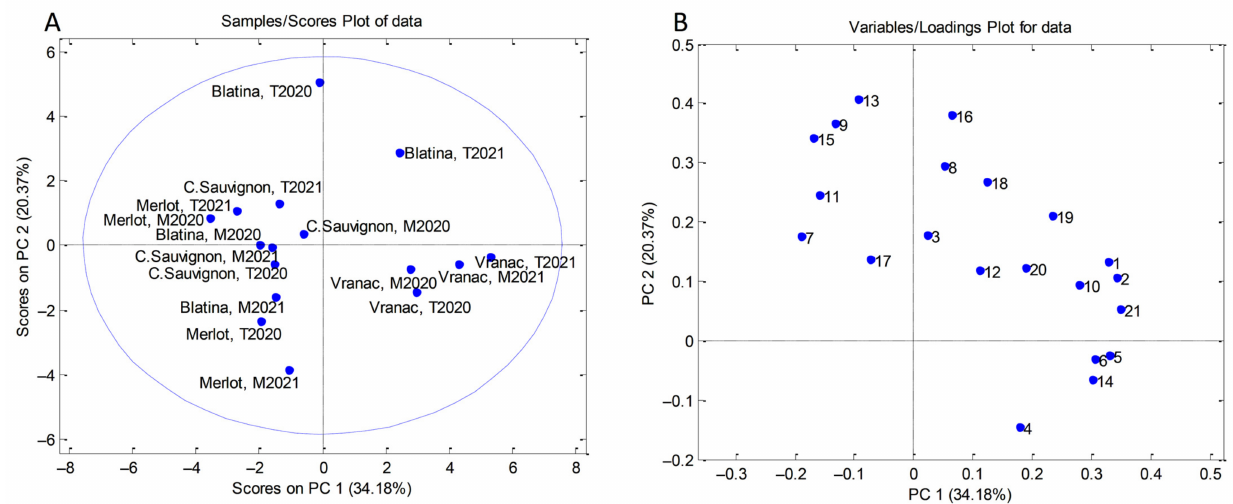
Figure 3. PCA analysis performed on data obtained from phenolic profiles (individual polyphenols, TPC, and RSA) of grape samples: ( A ) score plot and ( B ) loading plot (number of compounds corresponds to Table